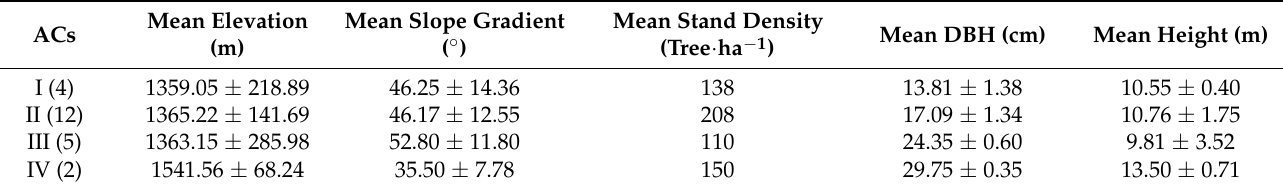
Table 1. Basic information regarding different ACs of